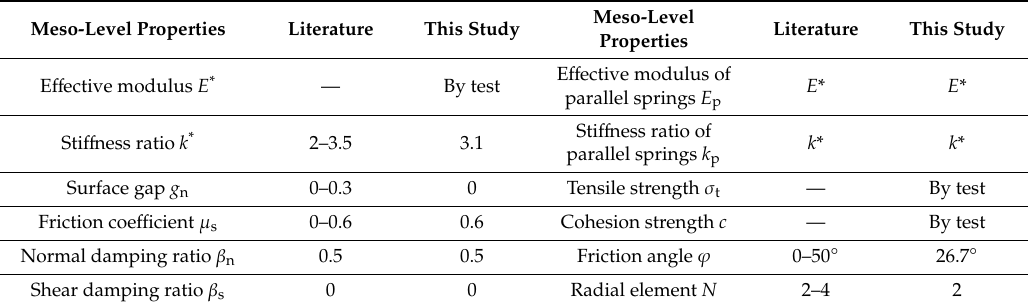
Table 2. Parameters adopted in the flat joint